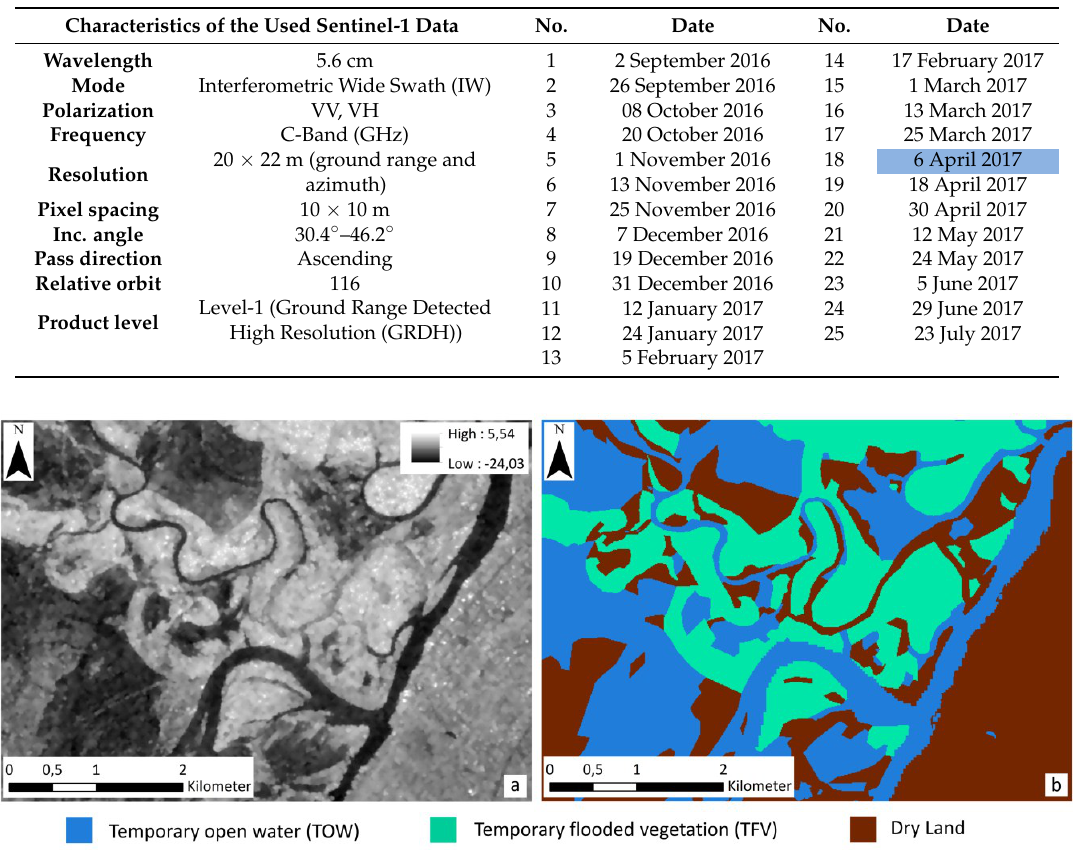
Figure 2. Validation extent of the preprocessed S-1 image at the flood event (6 April 2017) for VV polarization ( a ). Digitized validation mask based on S-2 data (8 April 2017) ( b ).